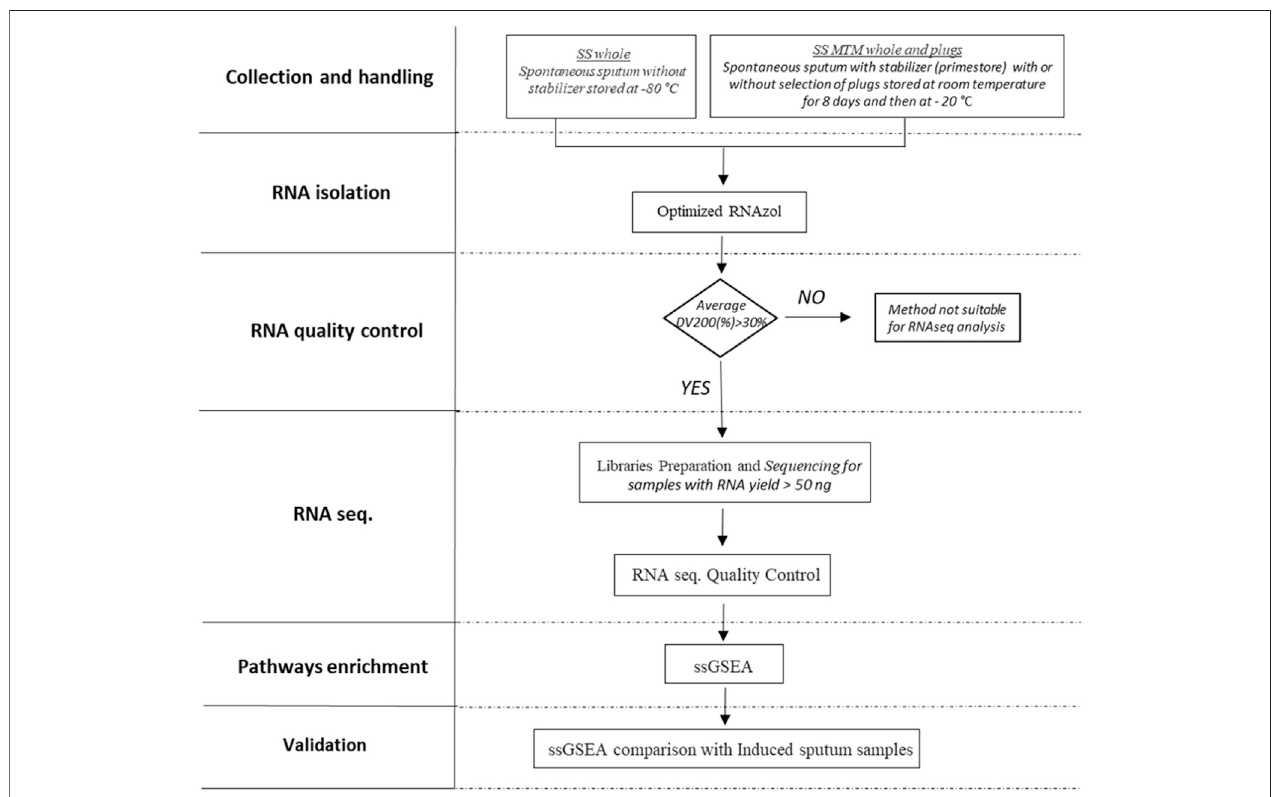
FIGURE 1 | Spontaneous sputum samples without stabilizer ( SS_whole ) and SS with stabilizer ( SS_MTM ) were collected with ( SS_MTM_plug ) or without ( SS_MTM_whole ) selection of plugs. RNA was extracted using an optimized RNAzol ® protocol. An average DV 200 above 30% was considered suitable for progression to RNAseq analysis. Only samples with RNA content higher than 50 ng were submitted to library preparation and sequencing. Finally, the outcome of ssGSEA was validated with ssGSEA results from an independent set of processed induced